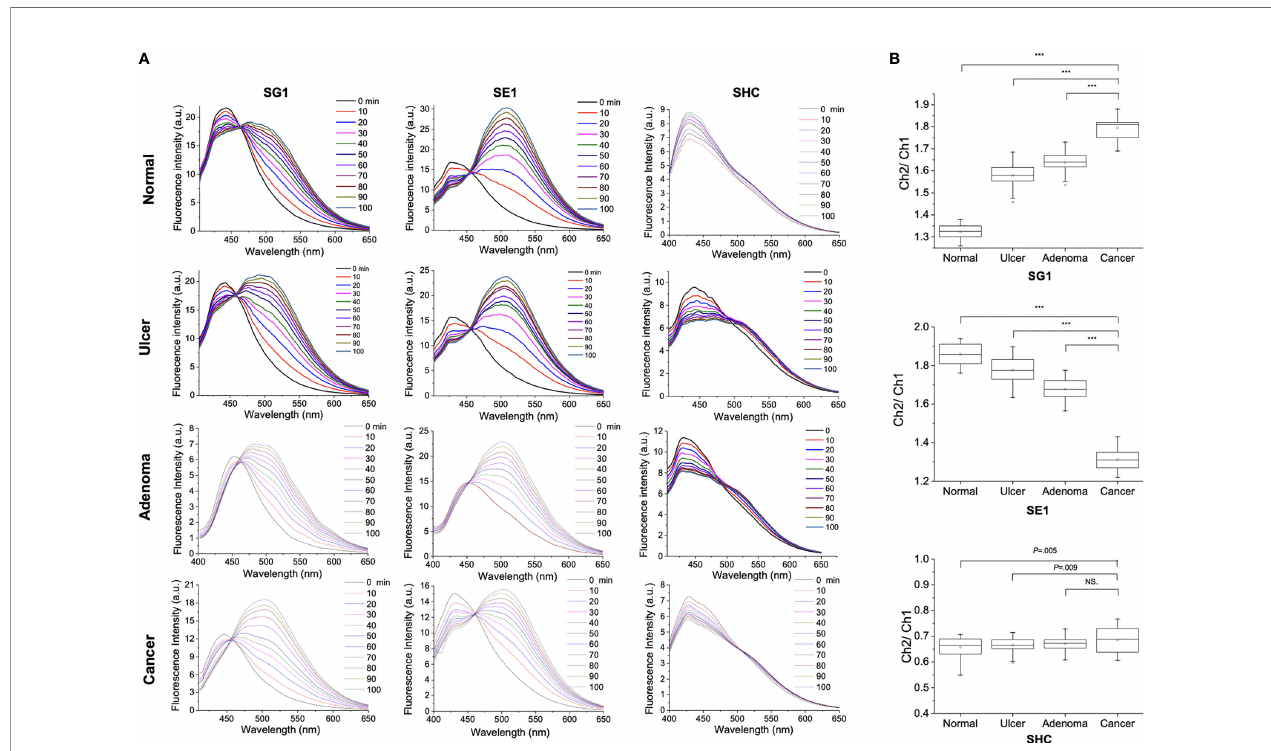
FIGURE 9 | (A) Fluorescence response over time for 1 m M SG1, SE1, and SHC reactions with normal and cancerous stomach tissues treated with lysis buffer (T-PER). (B) Box plot of the relative ratio value (Ch2/Ch1) from spectra (*** P < 0.001, NS, not signi fi